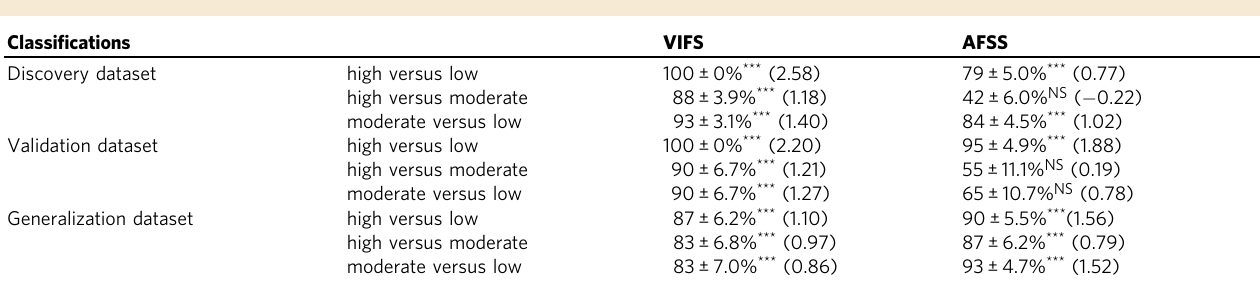
Table 1 Comparing performance of VIFS with